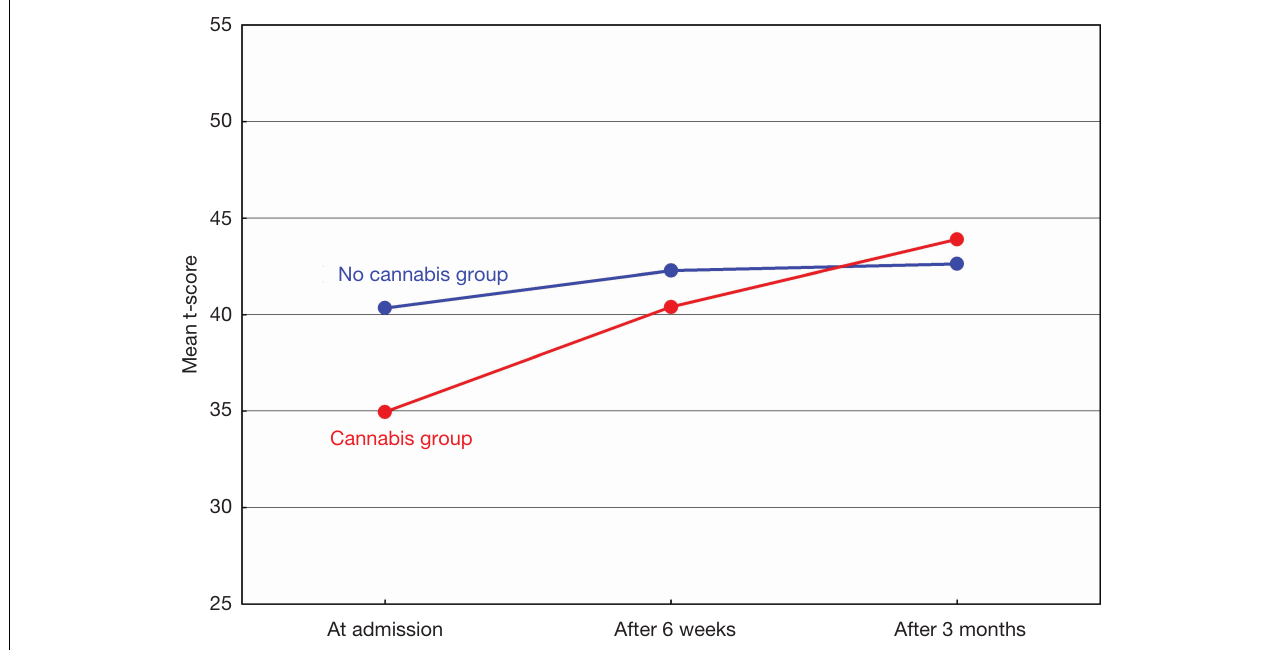
FIGURE 2 | Mean neuropsychological T-scores for the cannabis and no-cannabis group at admission, after 6 weeks and 3